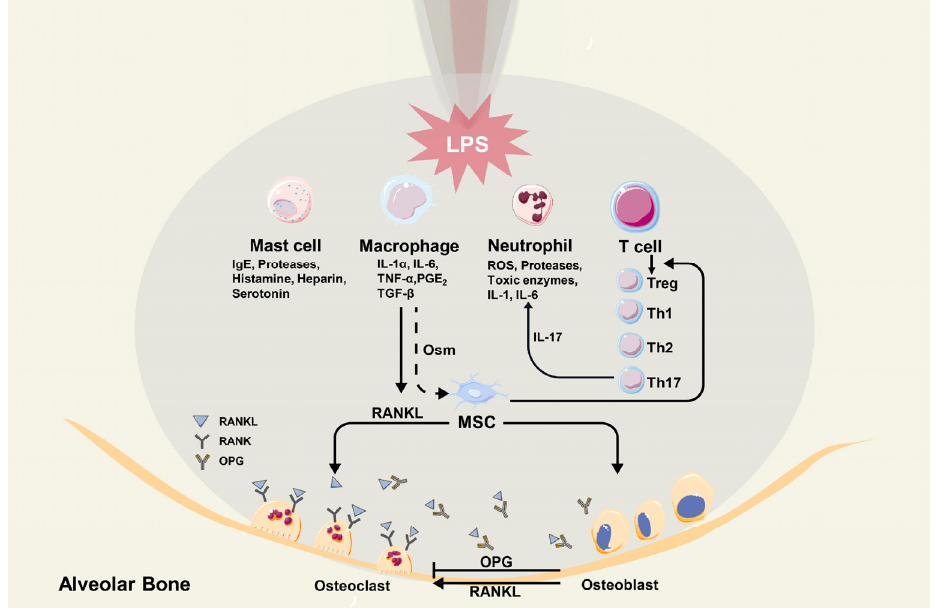
Figure 1. The immuno-microenvironment in a periapical lesion.